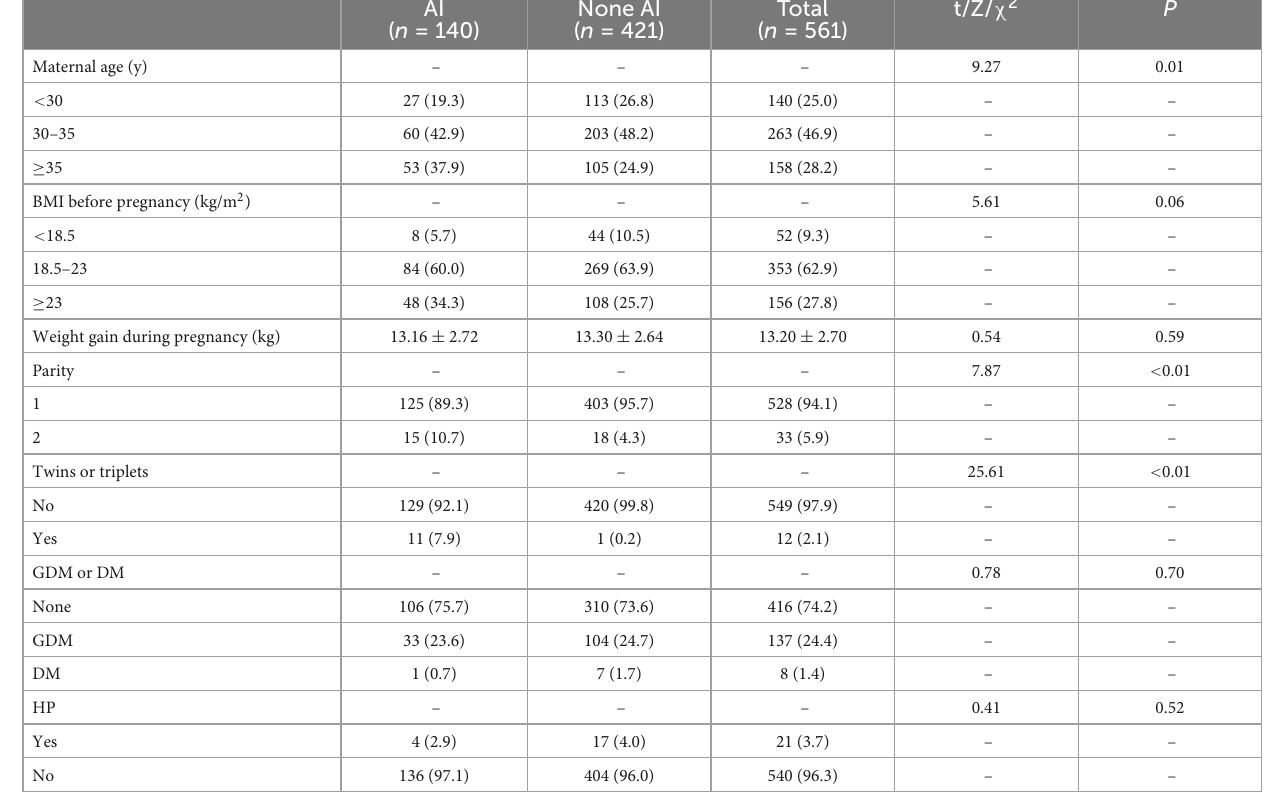
TABLE 2 Maternal risk factors associated with AI a